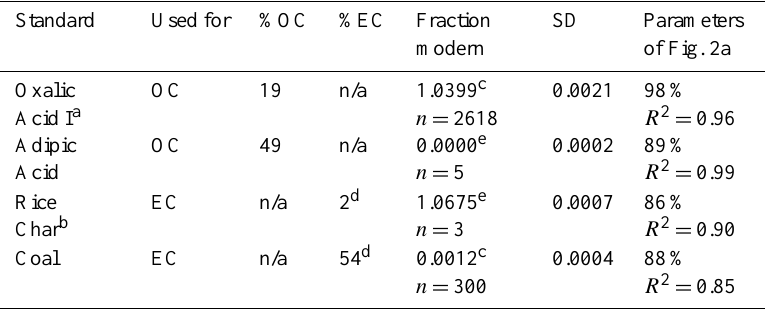
Table 1. Description of reference materials used for quantifying background contamination and method accuracy of OC and EC trapping and 14 C measurements. Parameters of Fig. 2a regard the measured volume vs. expected yield and the coefficient of determination of the linear regression for the individual reference materials as explained in Sect. 3.1.